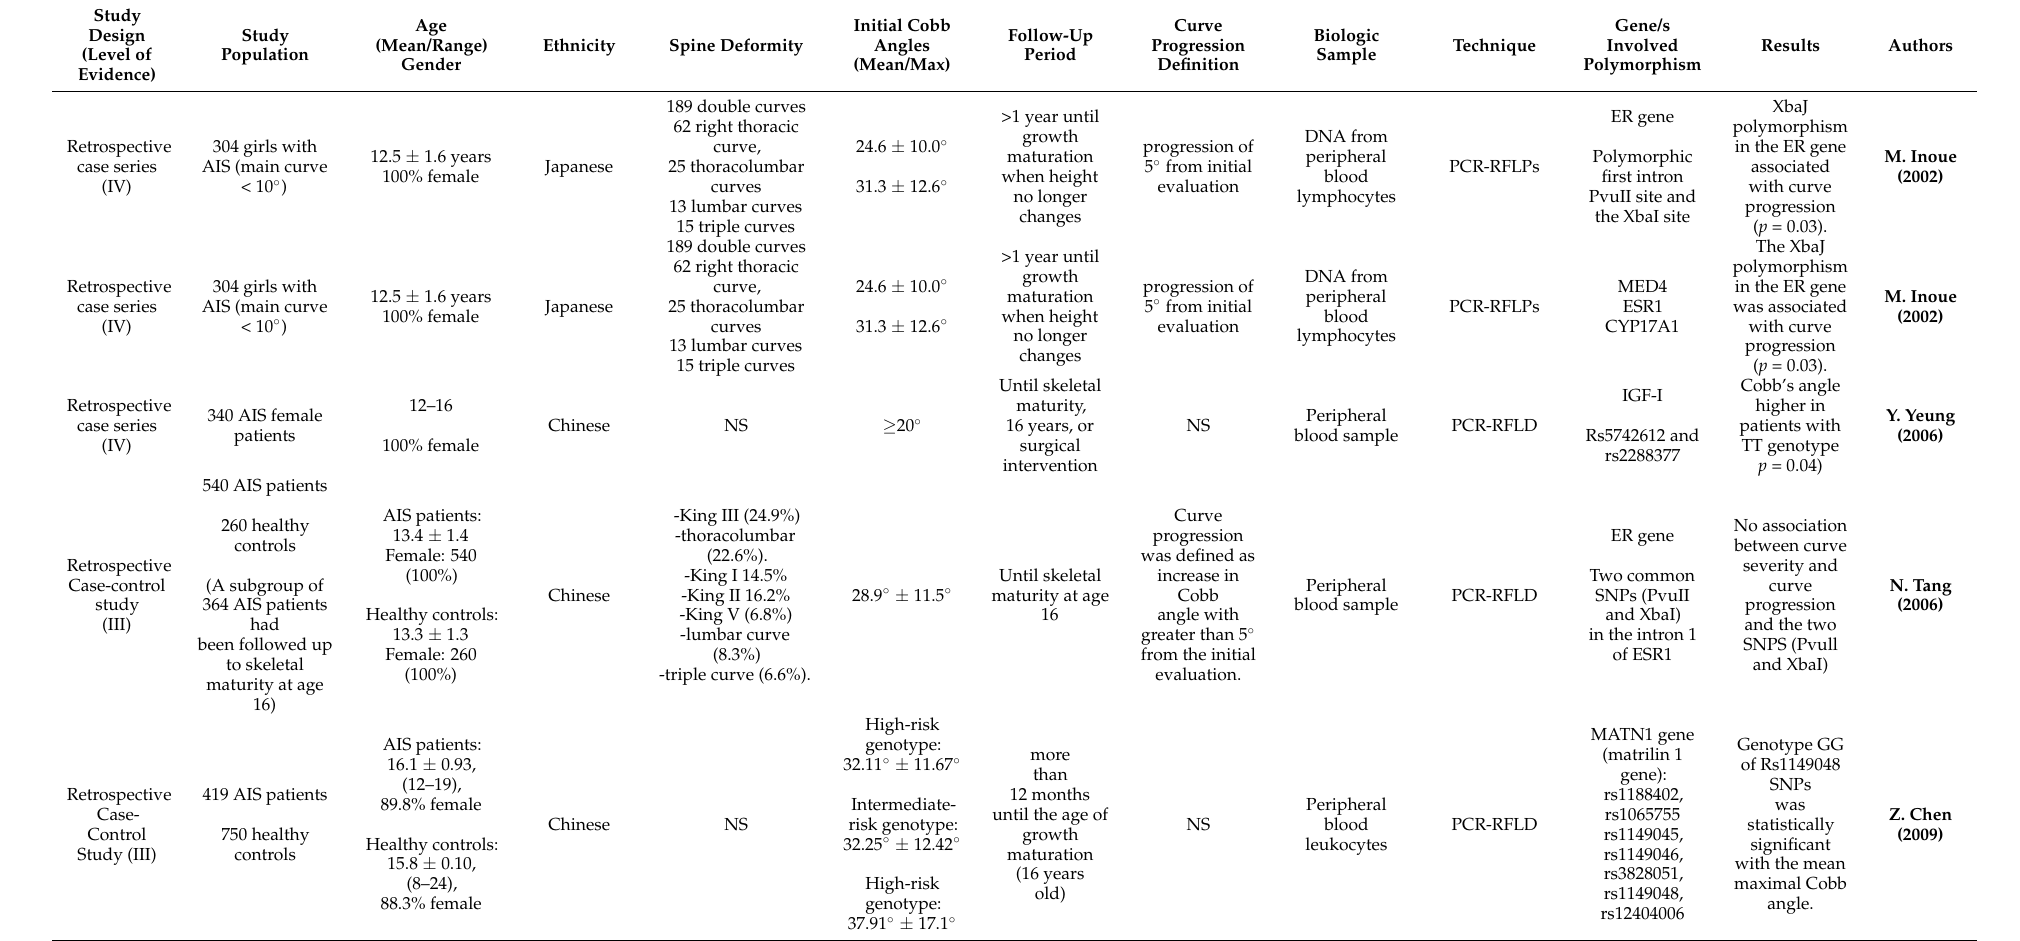
Table 1. Details of the included studies. (NS = non